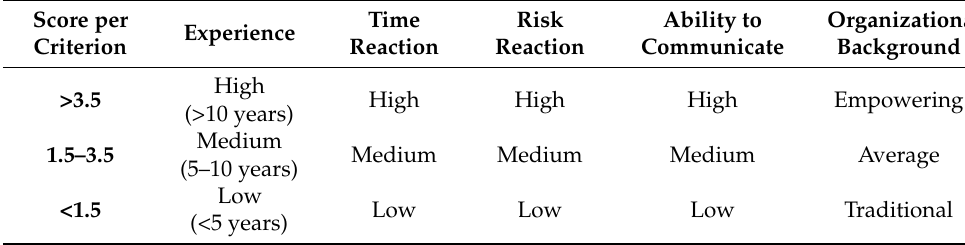
Table 1. Improvisers’ criteria and classification.